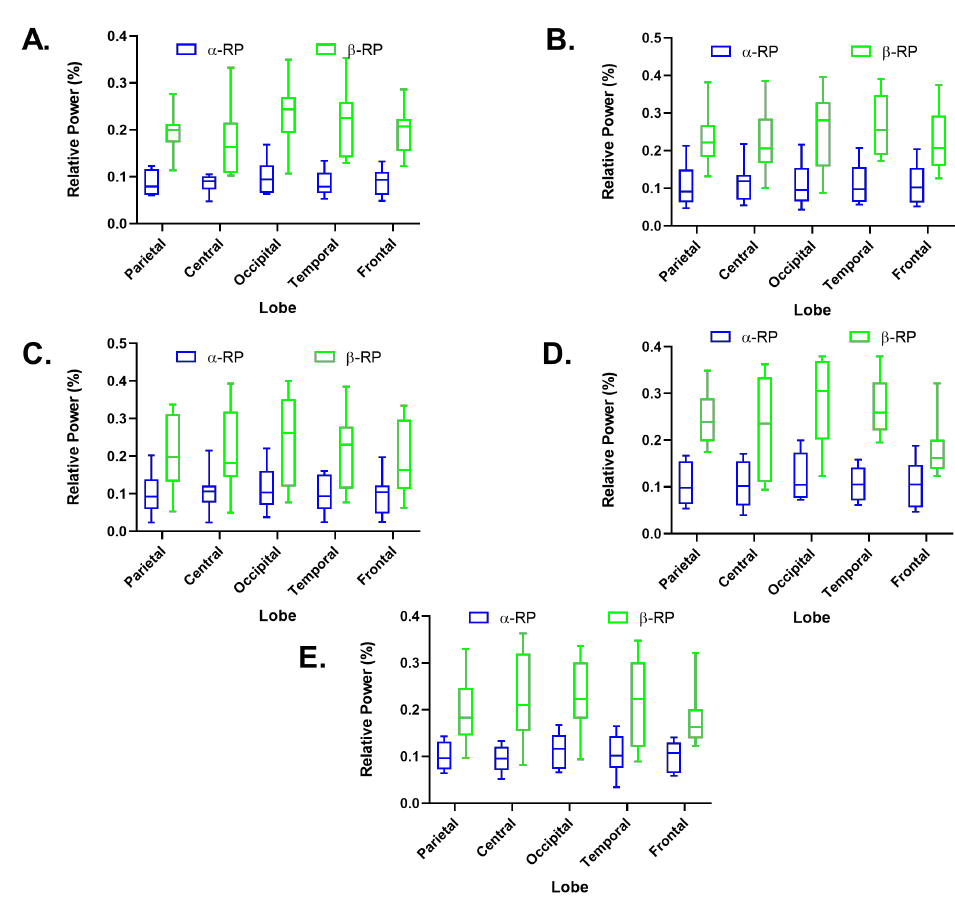
Figure 4. Distribution of the alpha and beta bands’ relative power by cerebral lobes of the software Hand Physics Lab games. ( A ) Finger Painting (FP). ( B ) Sorting Cubes (SC). ( C ) More Switches (MS). ( D ) Zero Gravity Switches (ZG). ( E ) and Punch the Dummy